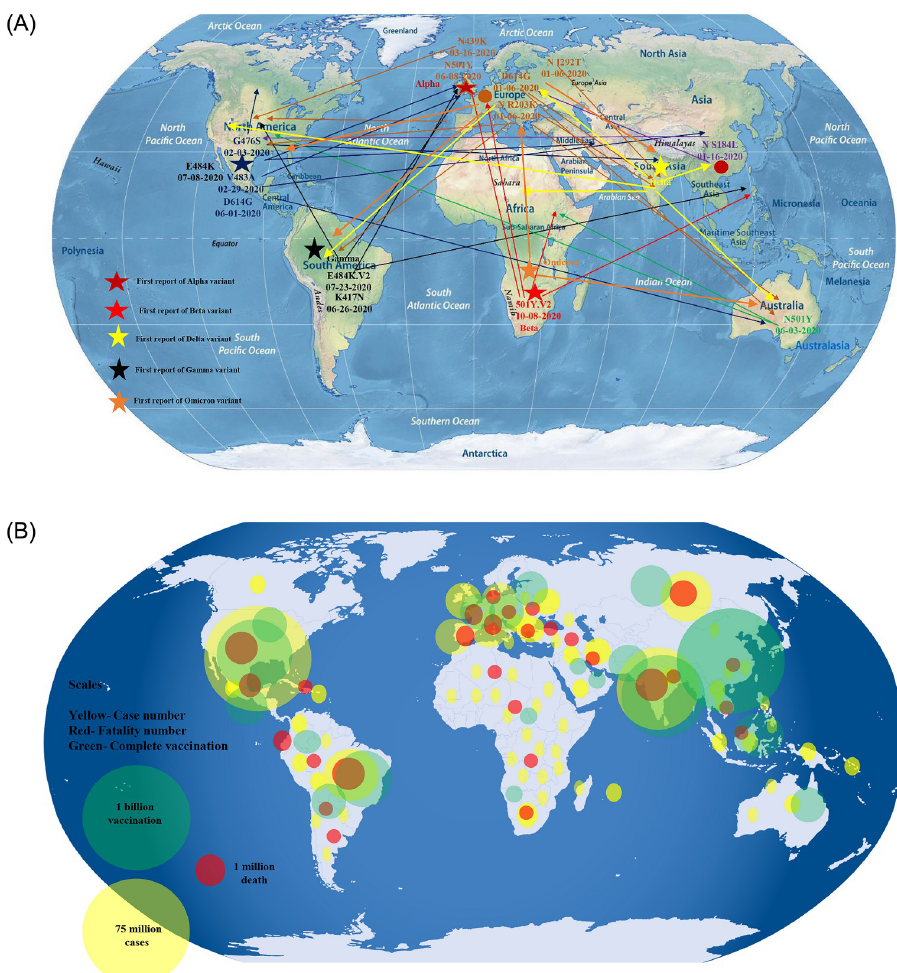
January, 2022 about 7540558 whole genome of SARS-CoV-2 were traced worldwide. Four variants of concern including beta, gamma, delta and omicron with their probable transmission history were indicated by four different color lines. Star and circle indicated probable origin places. (B) Worldwide distribution of cumulative case, fatality and complete vaccination number of COVID-19 till 31 January,